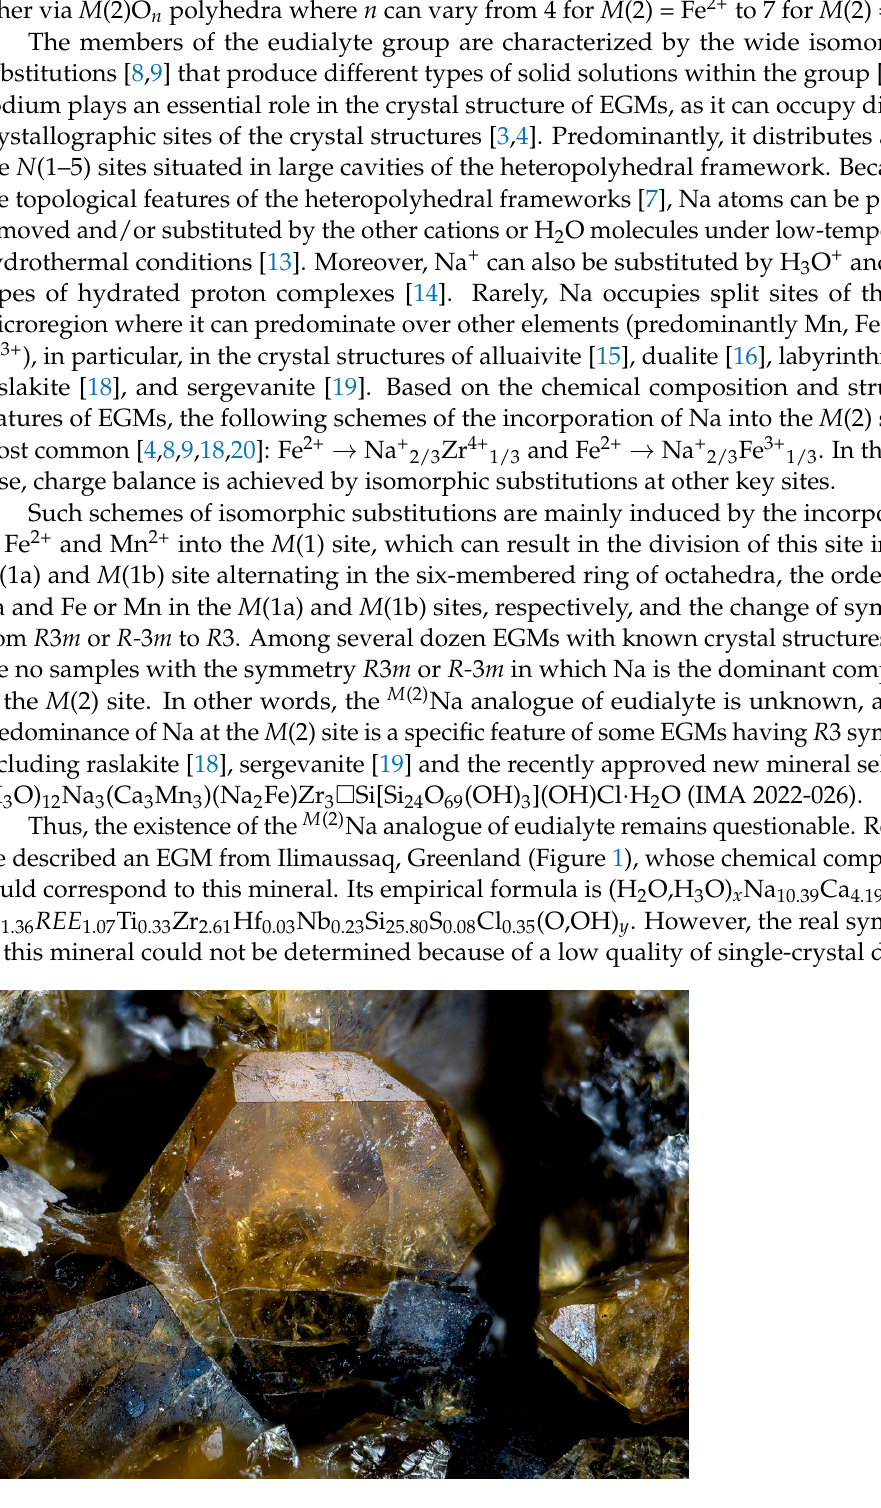
Figure 1. Crystal of a Fe,Mn-deficient EGM from the Ilimaussaq massif. Field of view width: 1 mm. Photographer: Volker Heck.